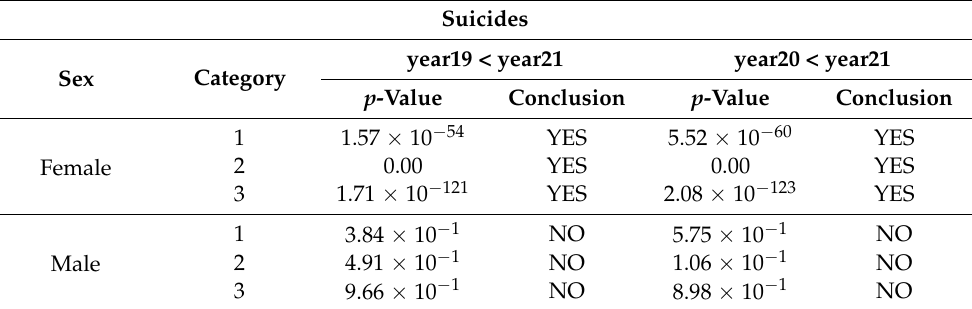
Table 8. Summary of test results for proportions—deaths by